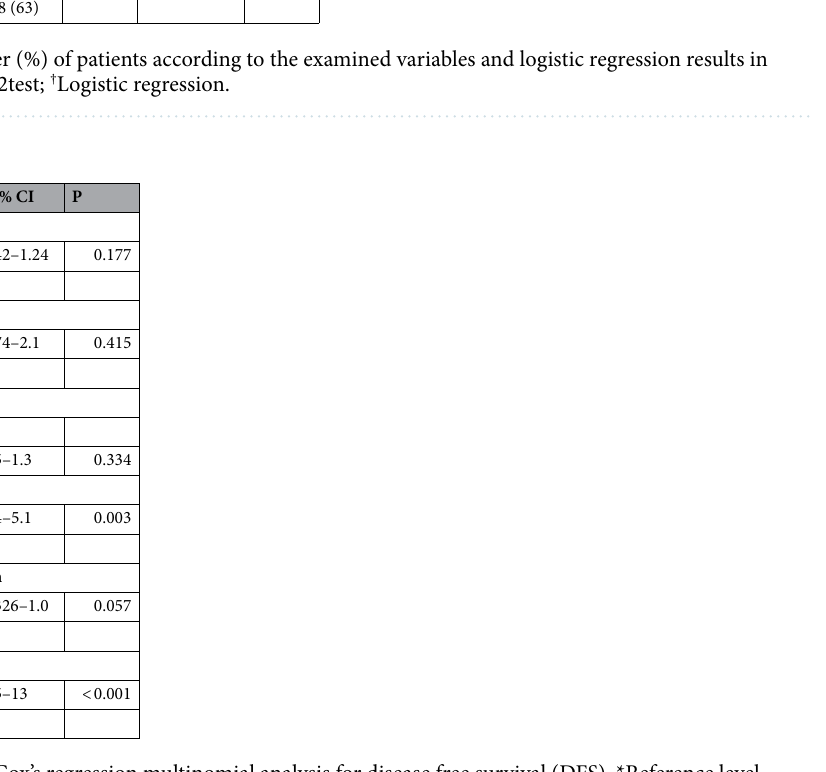
Table 3. Results of Cox’s regression multinomial analysis for disease free survival (DFS). *Reference level.